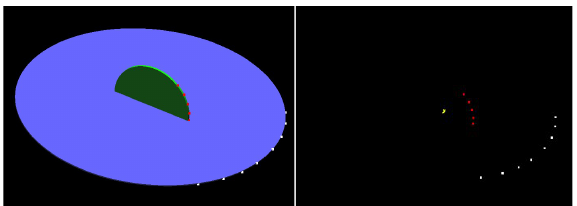
Figure 10. The calibration of the non-motorized camera mount. The sub-image locations before the mount calibration are presented in the left image. In the right the image, yellow dots represent the sub-image locations after the mount calibration.